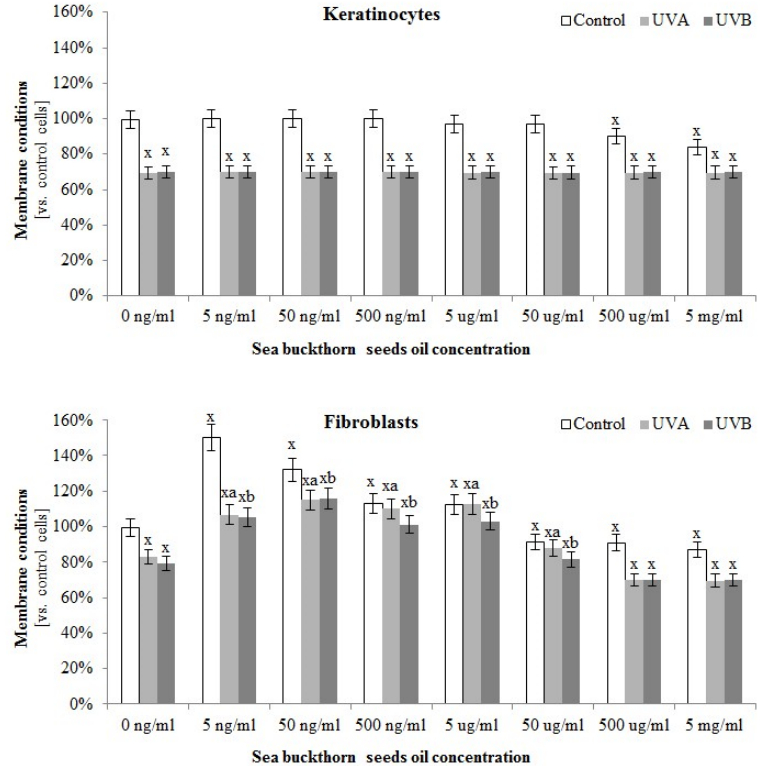
Figure 3. The effect of different concentrations ranging 50 ng/mL–5 µ g/mL of sea buckthorn seed oil on the membrane conditions of control and UV irradiated keratinocytes and fibroblasts measured by LDH test. Total doses of UV irradiation for each cell line were: 30 J/cm 2 and 60 mJ/cm 2 for keratinocytes, and 20 J/cm 2 and 200 mJ/cm 2 for fibroblasts for UVA and UVB, respectively. Mean values ± SD of five independent experiments are presented. x statistically significant differences vs. control group, p < 0.05; y statistically significant differences between UVA/UVB and oil treated groups vs. oil treated control group, p < 0.05; a statistically significant differences between UVA and oil treated group vs. UVA treated group, p < 0.05; b statistically significant differences between UVB and oil treated group vs. UVB treated group, p < 0.05.